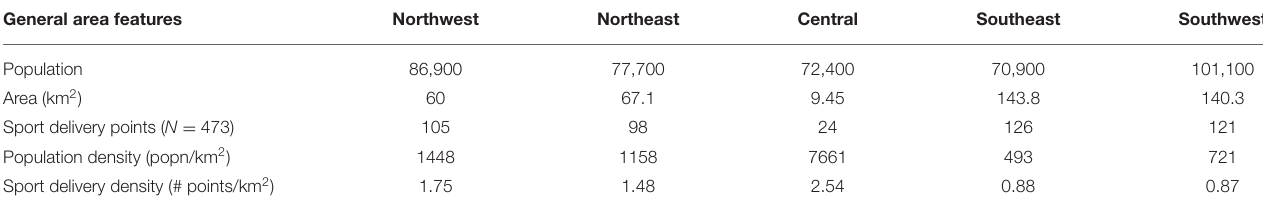
TABLE 3 | City of London planning areas profile and sport delivery